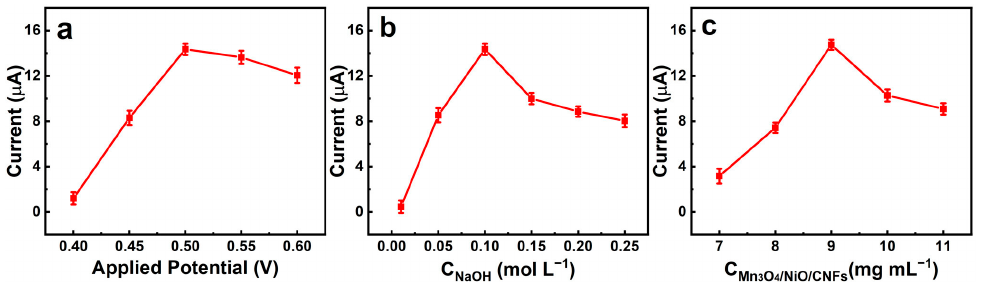
Figure 5. Optimization of parameters on the current response of 0.5 mM glucose: ( a ) applied potential; ( b ) the concentration of NaOH; ( c ) the content of Mn 3 O 4 /NiO/CNFs.